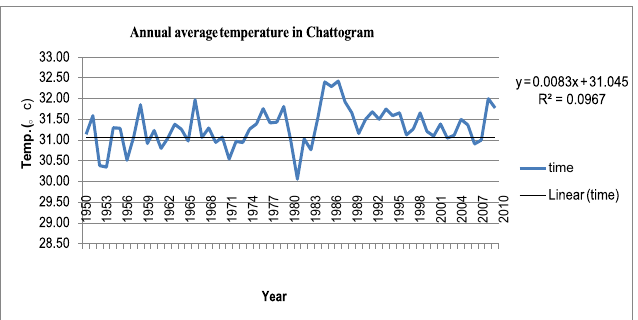
Figure 2: Long term (1950-2010) trend of annual average temperature in Chattogram